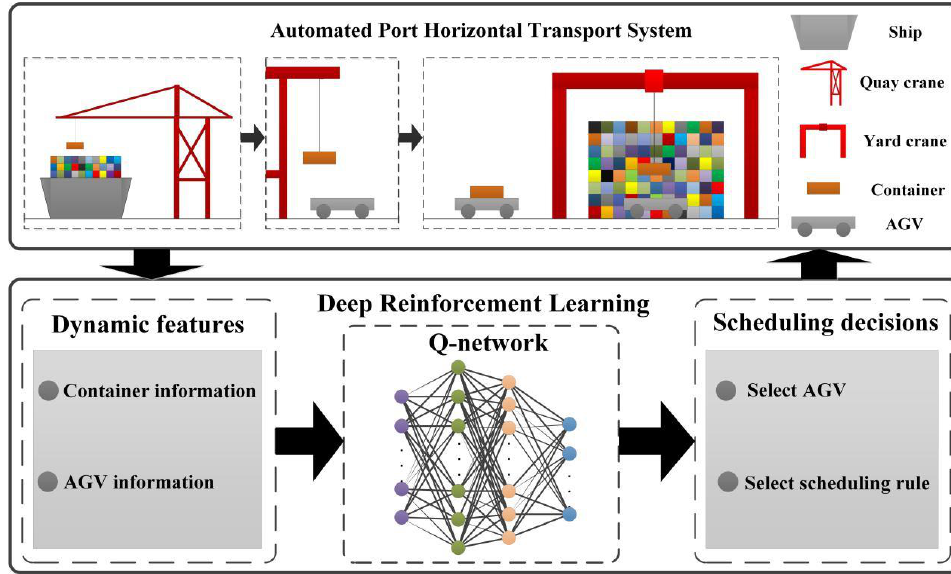
Figure 2. DQN-based dynamic scheduling method architecture of the automated terminal AGVs.